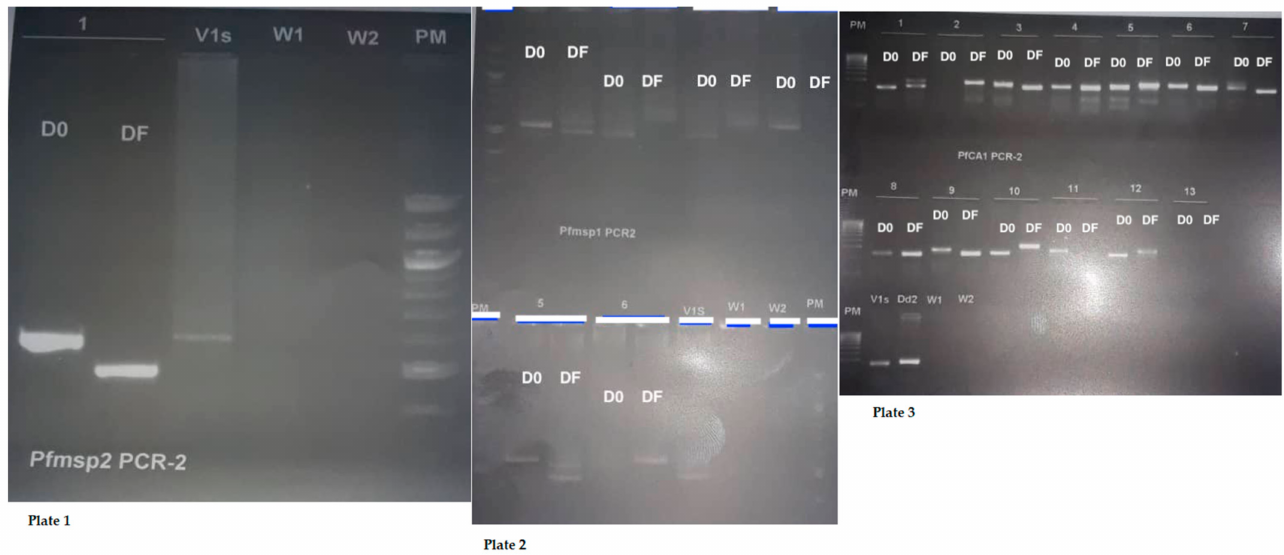
Figure 6. Gel photo illustrations for MSP2, MSP1, and Ca1 (D0 = Day 0 and DF = Failure Day). ( Plate 1 ). DNA band of Plasmodium falciparum MSP2. ( Plate 2 ). DNA band of P. falciparum MSP1. ( Plate 3 ). DNA band of microsatellite